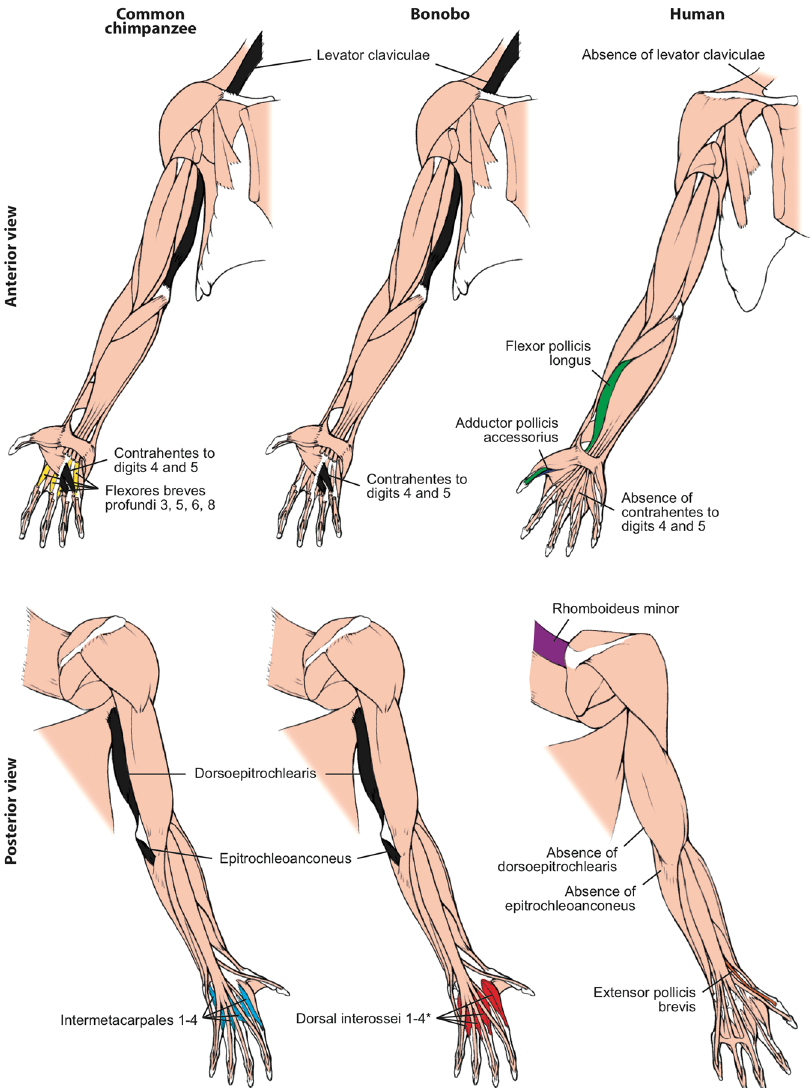
Figure 2. Differences between forelimb muscles of common chimpanzees, bonobos and modern humans. The only consistent difference between bonobos (center) and common chimpanzees (left) concerning the presence/ absence of muscles (shown in colors in the common chimpanzee and bonobos schemes) is that in the former the intermetacarpales 1–4 are usually fused with the flexores breves profundi 3, 5, 6 and 8 to form the dorsal interossei muscles 1–4 ( * in bonobo) figure, as is the case in modern humans. In contrast, there are many differences between bonobos and modern humans (right) concerning the presence/absence of muscles (shown in colors and/or with labels in the human scheme; muscles present in chimpanzees and not in humans are shown in black, in chimpanzees). See text for more